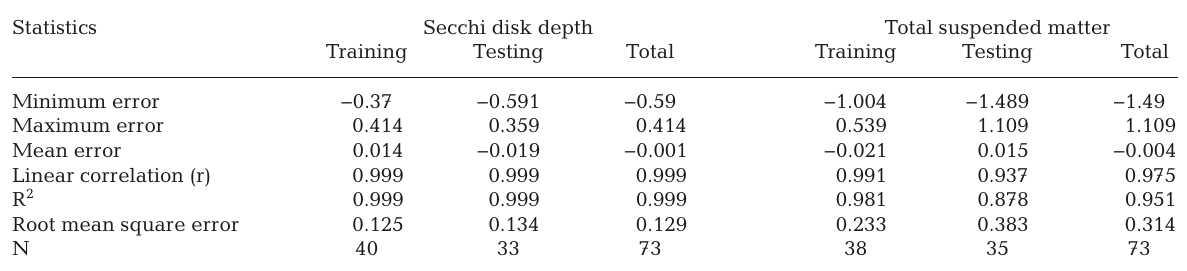
Table 2. Resulting features of the networks and statistical comparison of neural network training, testing, and total